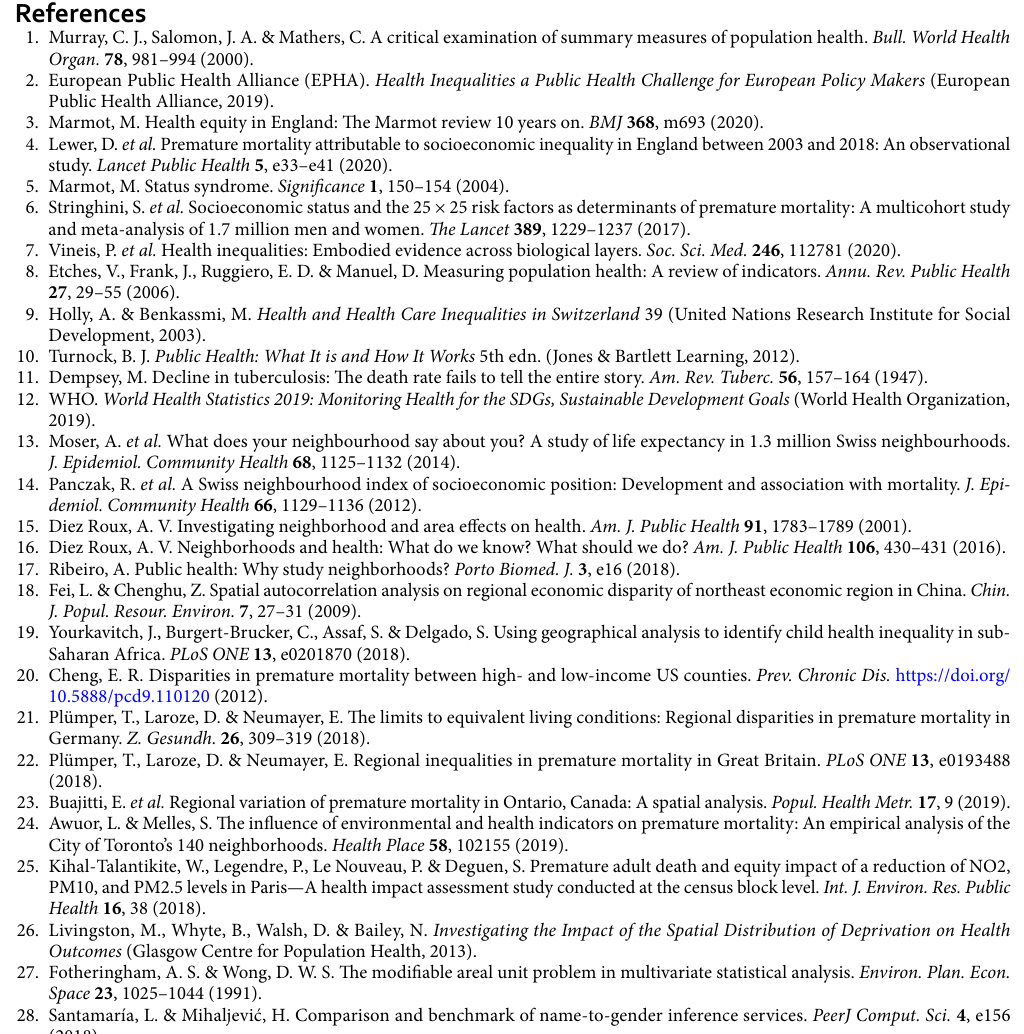
Figure 2. Spatial footprint of YPLLG for the adjusted model. ( A ) Local Moran cluster map was calculated for a random subset of 10,000 individuals taken from the 22,751 individuals in the state of Geneva for the 2009–2016 period (Subset 8). White dots represent individuals without spatial dependence (i.e., those whose Local Moran’s I p-values adjusted with Bonferroni are not significant). Dark green dots (High–High cluster) represent individuals with high adjusted YPLLG values (i.e., those that that lived longer than expected) surrounded by individuals with similar values within a distance of 1200 m. Dark purple dots (Low–Low cluster) represent individuals with low adjusted YPLLG values (i.e., those that lived shorter than expected) surrounded by individuals with similar values. Light purple dots (Low–High spatial outliers) represent individuals with high adjusted YPLLG values surrounded by individuals with low adjusted YPLLG values, and light green dots (High– Low spatial outliers) represent individuals with low adjusted YPLLG values surrounded by individuals with high adjusted YPLLG values. Indicative landmarks are shown on the map to facilitate the interpretation of the results (#1–#8). [Source (administrative boundaries): https:// www. swiss topo. admin. ch/, 2020; the map was produced using R, package ggplot version 3.3.5.]. ( B ) Distribution of adjusted YPLLG values for each Local Moran cluster type ( LL Low–Low, LH Low–High, NS not significant, HL High–Low, HH